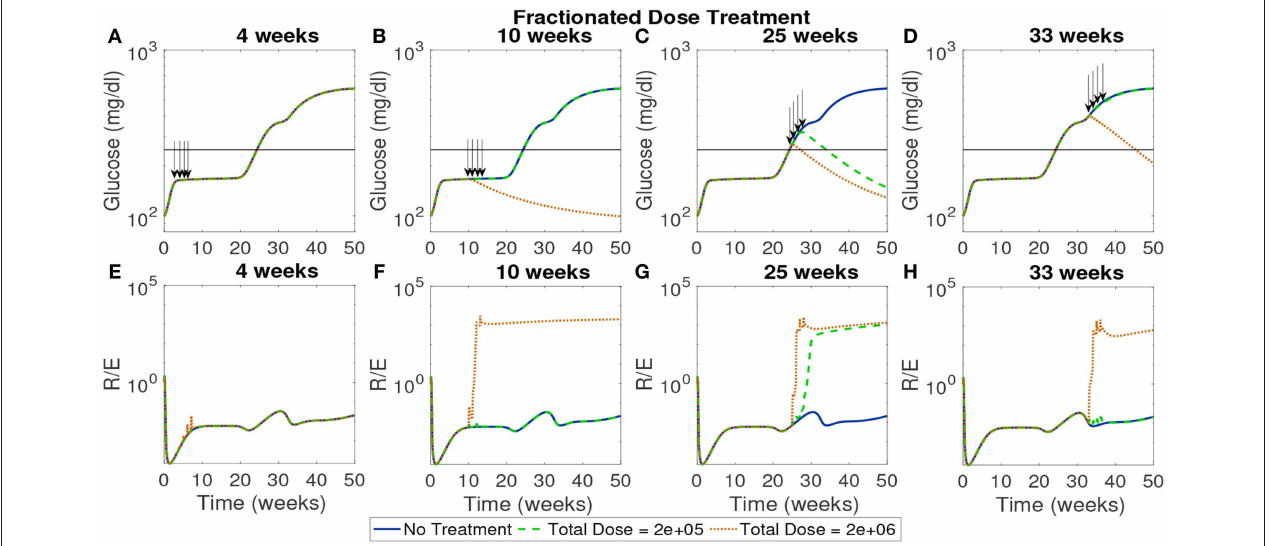
FIGURE 10 | The NOD mouse model simulated with doses of tolerogenic DCs administered in four weekly injections, for varying dose amounts and treatment start times. (A–D) Glucose levels for all treatment levels. (E–H) Ratio of regulatory to effector T cells for all treatment levels. (A) Early treatment is not effective when it is delivered in four weekly doses for both high and low dosing. (B) Only high doses are effective and in (C) we see that for later treatment start times both low and high doses are effective, however, in (D) we see that the low dose loses effectiveness similar to the case with one dose application.